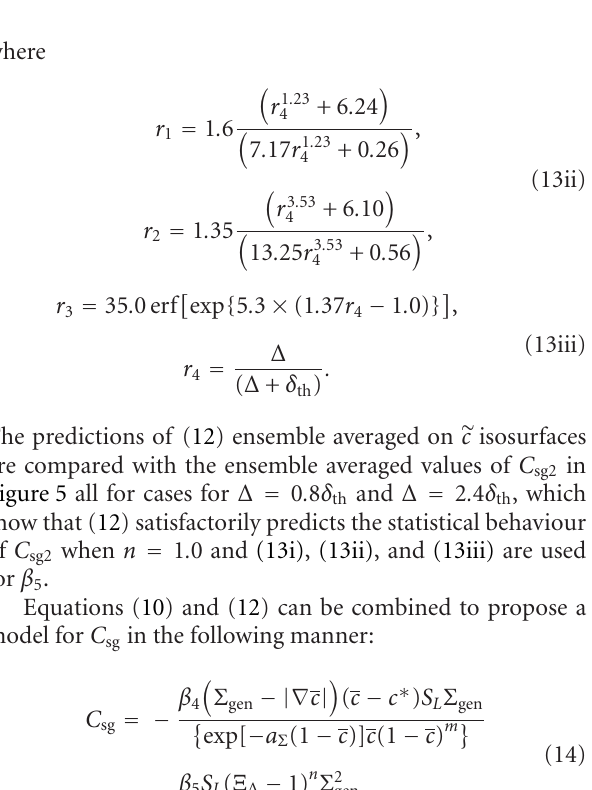
Figure 7: Variations of C sg conditionally averaged in bins of (cid:3) c across the flame brush for Δ = 8 Δ m ≈ 0 . 8 δ th (top row) and Δ = 24 Δ m ≈ 2 . 4 δ th (bottom row) for cases A (1st column), B (2nd column), C (3rd column), D (4th column), and E (5th column) along with the predictions of CSGCAND, CSGCANT, CSGCHAR, and CSGNEW.